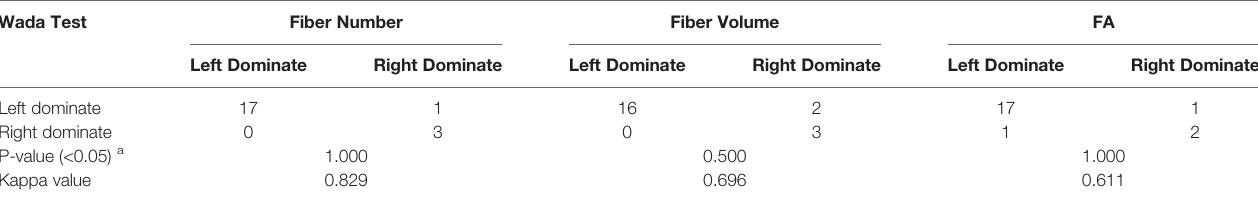
FA, fractional anisotropy. a McNemar